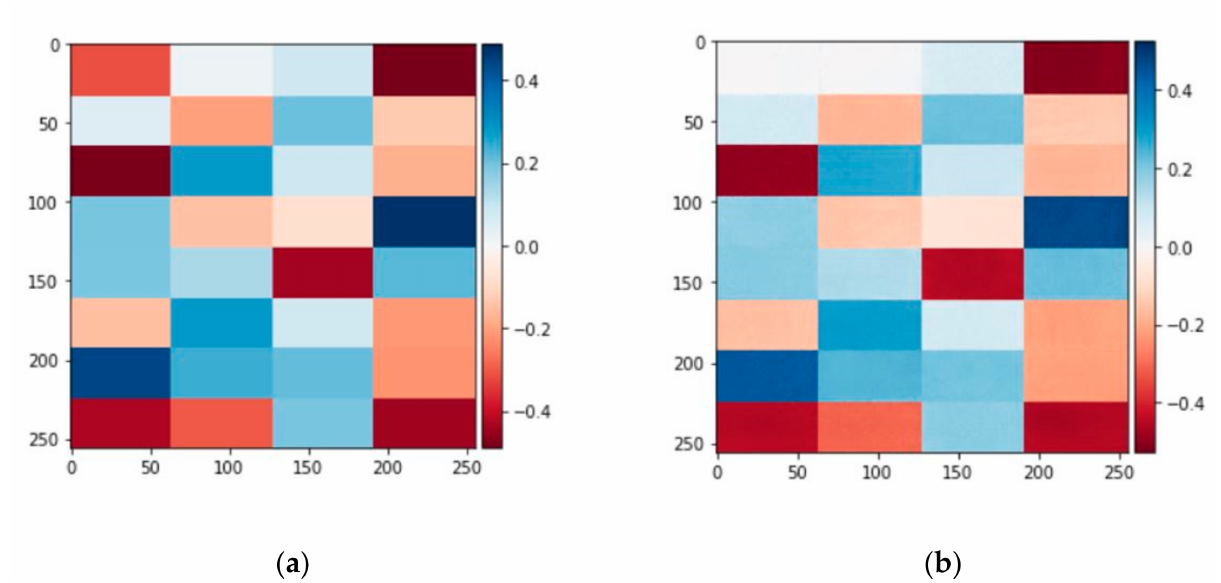
Figure 7. The mosaic image for 32 Zernike coefficients. ( a ) Target image (actual image). ( b ) The Generator’s output image (fake image).